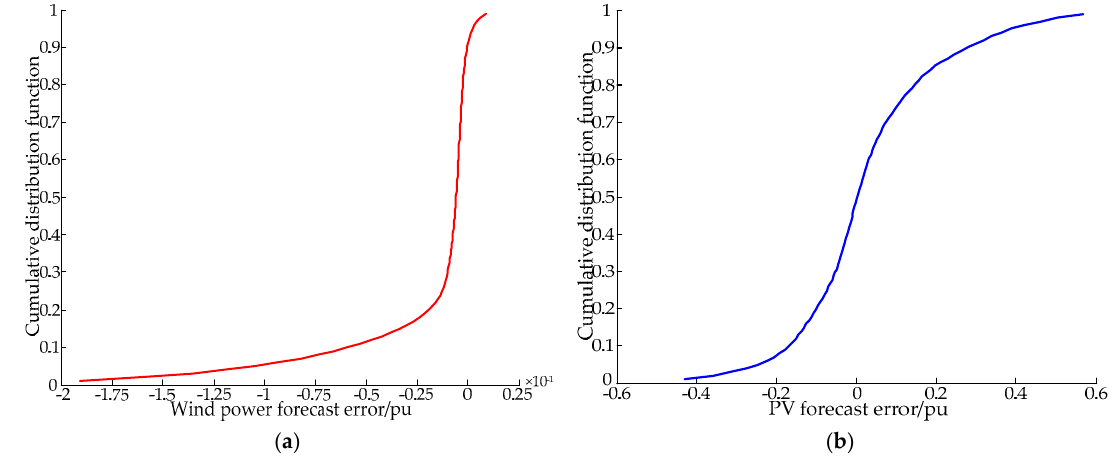
Figure 3. The forecast error cumulative distribution function curves of WP ( a ) and PV ( b ).